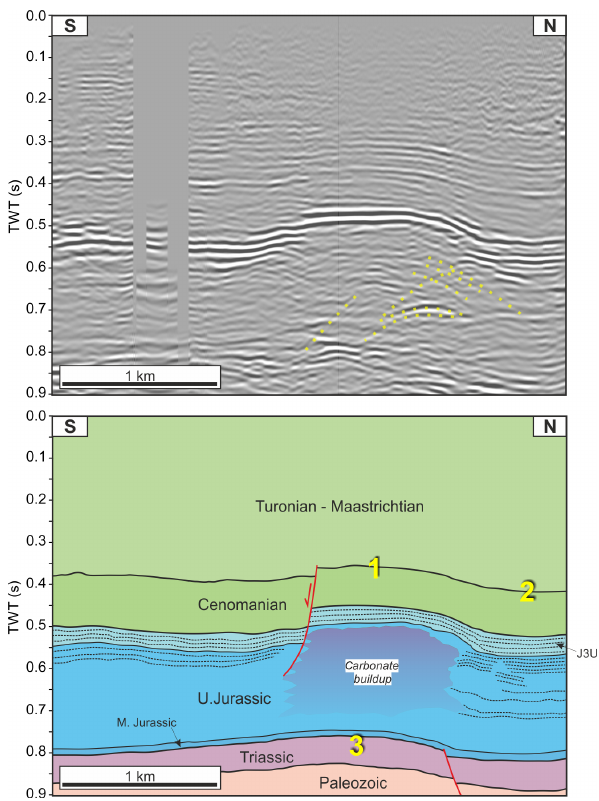
Figure 13. Uninterpreted and interpreted seismic profile across the carbonate buildup complex (see Fig. 5 for location). The effect of differential compaction between the carbonate sediments (gener- ally much higher for bedded carbonate facies, very low for massive limestones) can be clearly seen. Usually, these effects could also be visible within the younger, Upper Cretaceous overburden. As a re- sult, the younger strata also partly exhibit drape reflections (1) and compaction sag effects (2). Other characteristic seismic indicators can be also observed, i.e. the velocity pull-up effect for horizons be- low the buildup’s base (3) and the diffraction on the buildup’s edges (dotted yellow lines marked on the uninterpreted profile). Differen- tial compaction may have also led to the formation of normal faults along the borders of carbonate